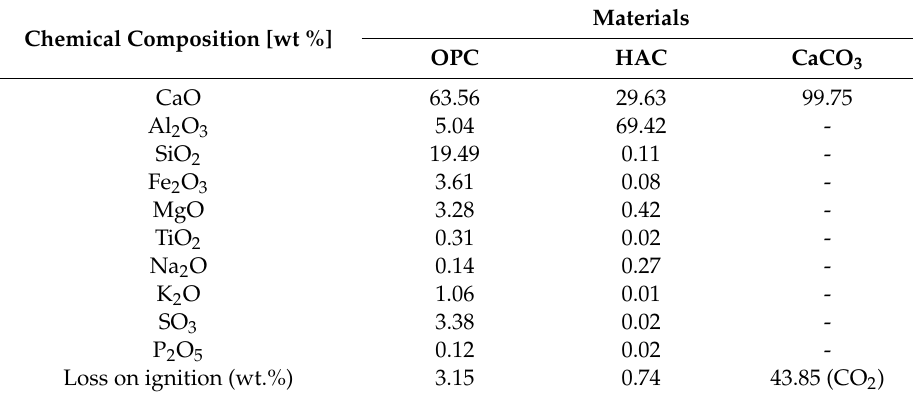
Table 1. Oxide composition of materials (wt % normalized to ~100%).